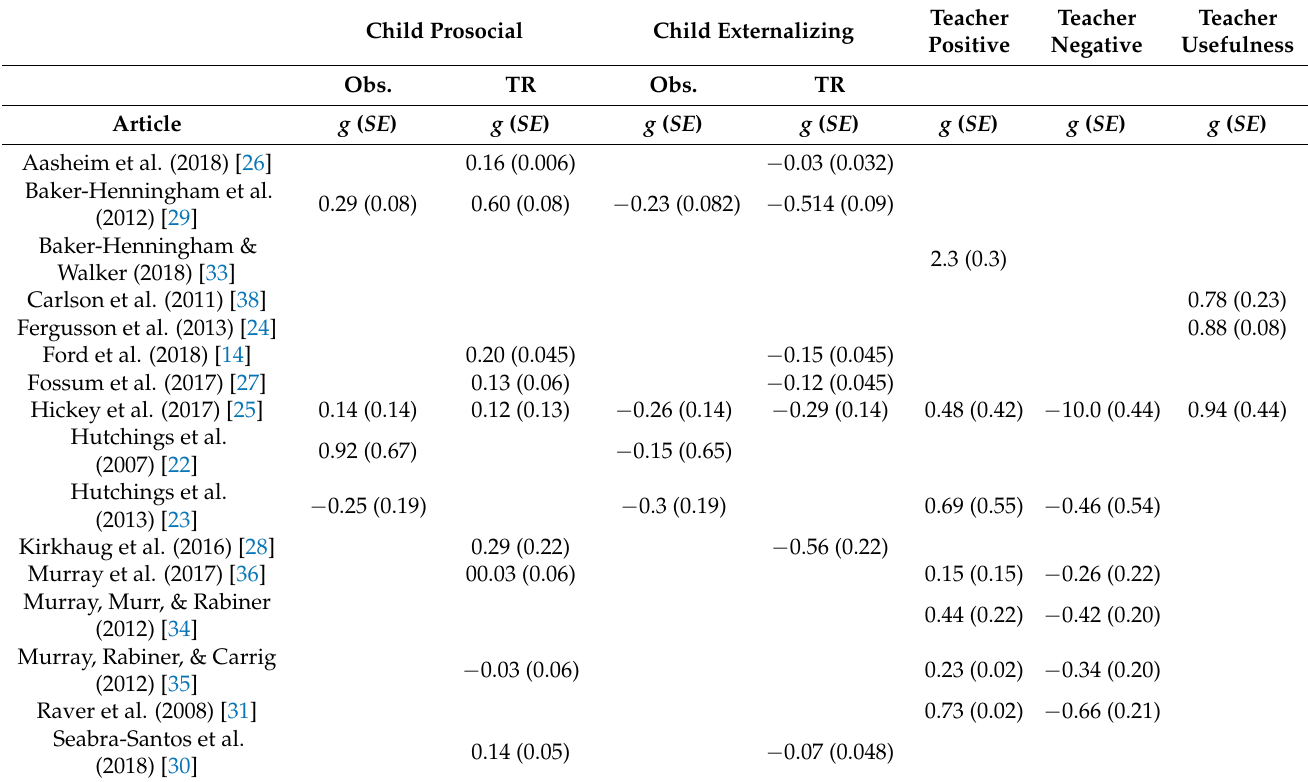
Table 3. Effect Sizes for IYTCM on Teacher and Child